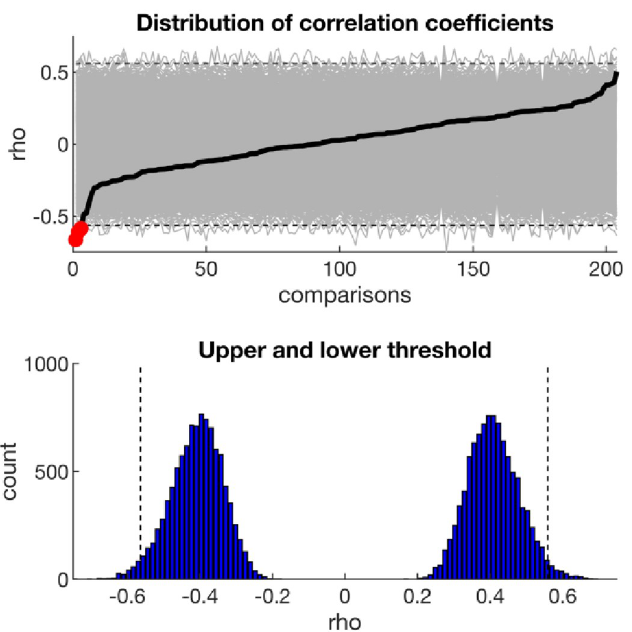
Fig 2. Permutation testing to control the family-wise error rate of mass bivariate analyses. Top panel shows the correlation coefficients for all 204 comparisons (black line) as well as the correlation coefficients of the 10,000 permutations (grey lines). The distribution of the most extreme statistic (bottom panel) was then used to determine adjusted significance threshold (dash line). Using this threshold only a few correlations are statistically significant (red dots, top panel).